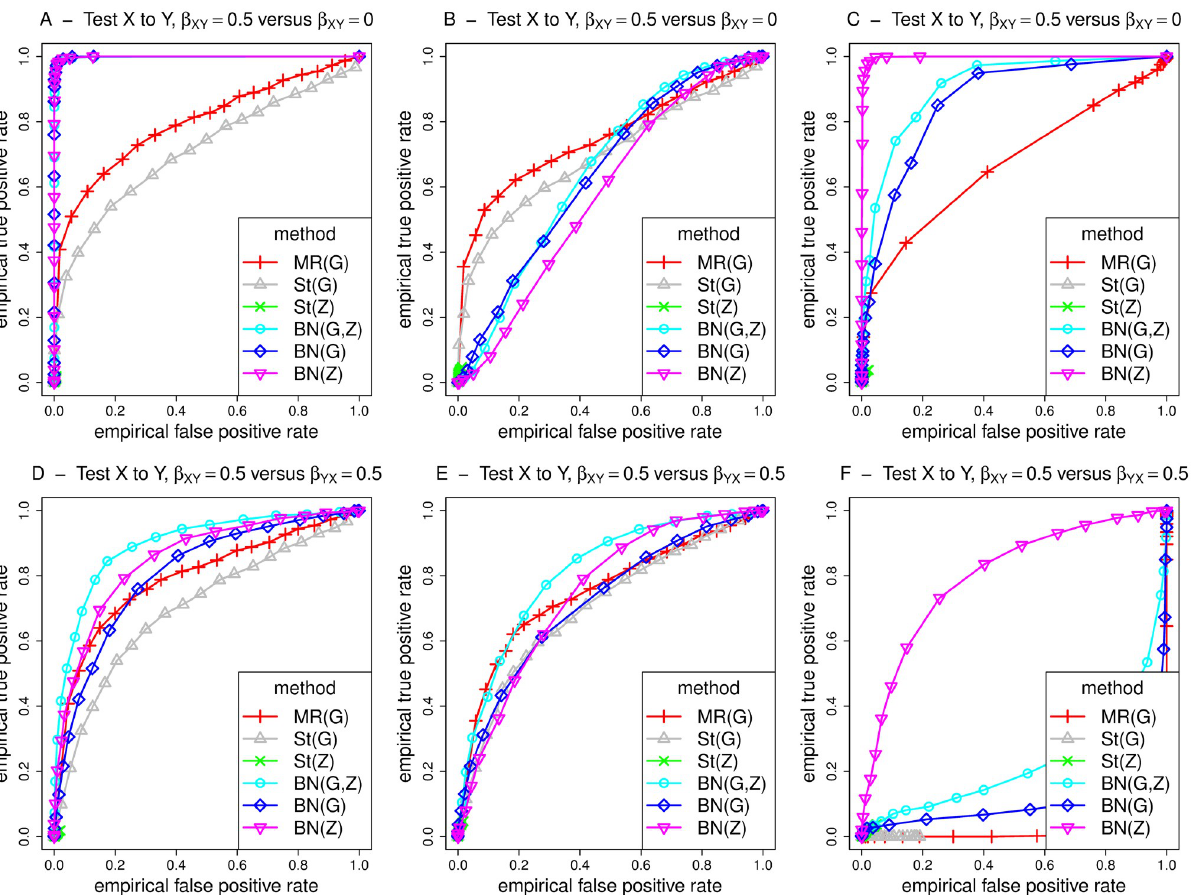
Fig 6. ROC curves for different methods for detecting an edge from X to Y, under different generating scenarios that include strong confounding. MR and St denote MR and MR Steiger respectively, performed using instrumental variable regression which takes into account the uncertainty of the predicted values in the first-stage regression to calculate the MR p -values. Left hand plots (A, D) are generated under model 1 (no confounding), middle plots (B, E) are generated under model 2 (non-genetic confounding), and right hand plots (C, F) are generated under model 3 (genetic confounding). For the top plots (panels A-C), false positives on the x-axis are counted using simulations when there is no effect ( β XY = 0), while for the bottom plots (panels D-F), the false positive rate is calculated by simulating from a model where there is a causal effect from Y to X.